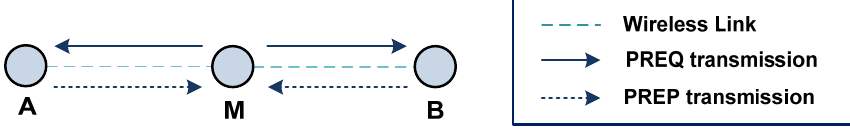
Figure 10. Example of an impersonation attack (path